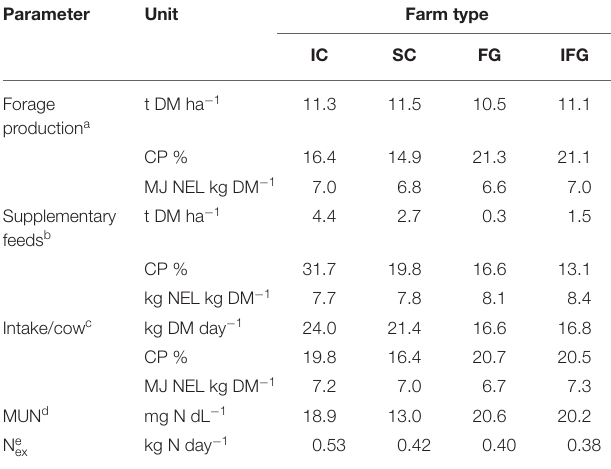
supplements) from the two experimental years, and the predicted milk urea (MUN) contents and annual N-excretion (N ex ) per cow among the different systems (IC, intensive-confinement; SC, semi-confinement; FG, full-grazed; IFG,